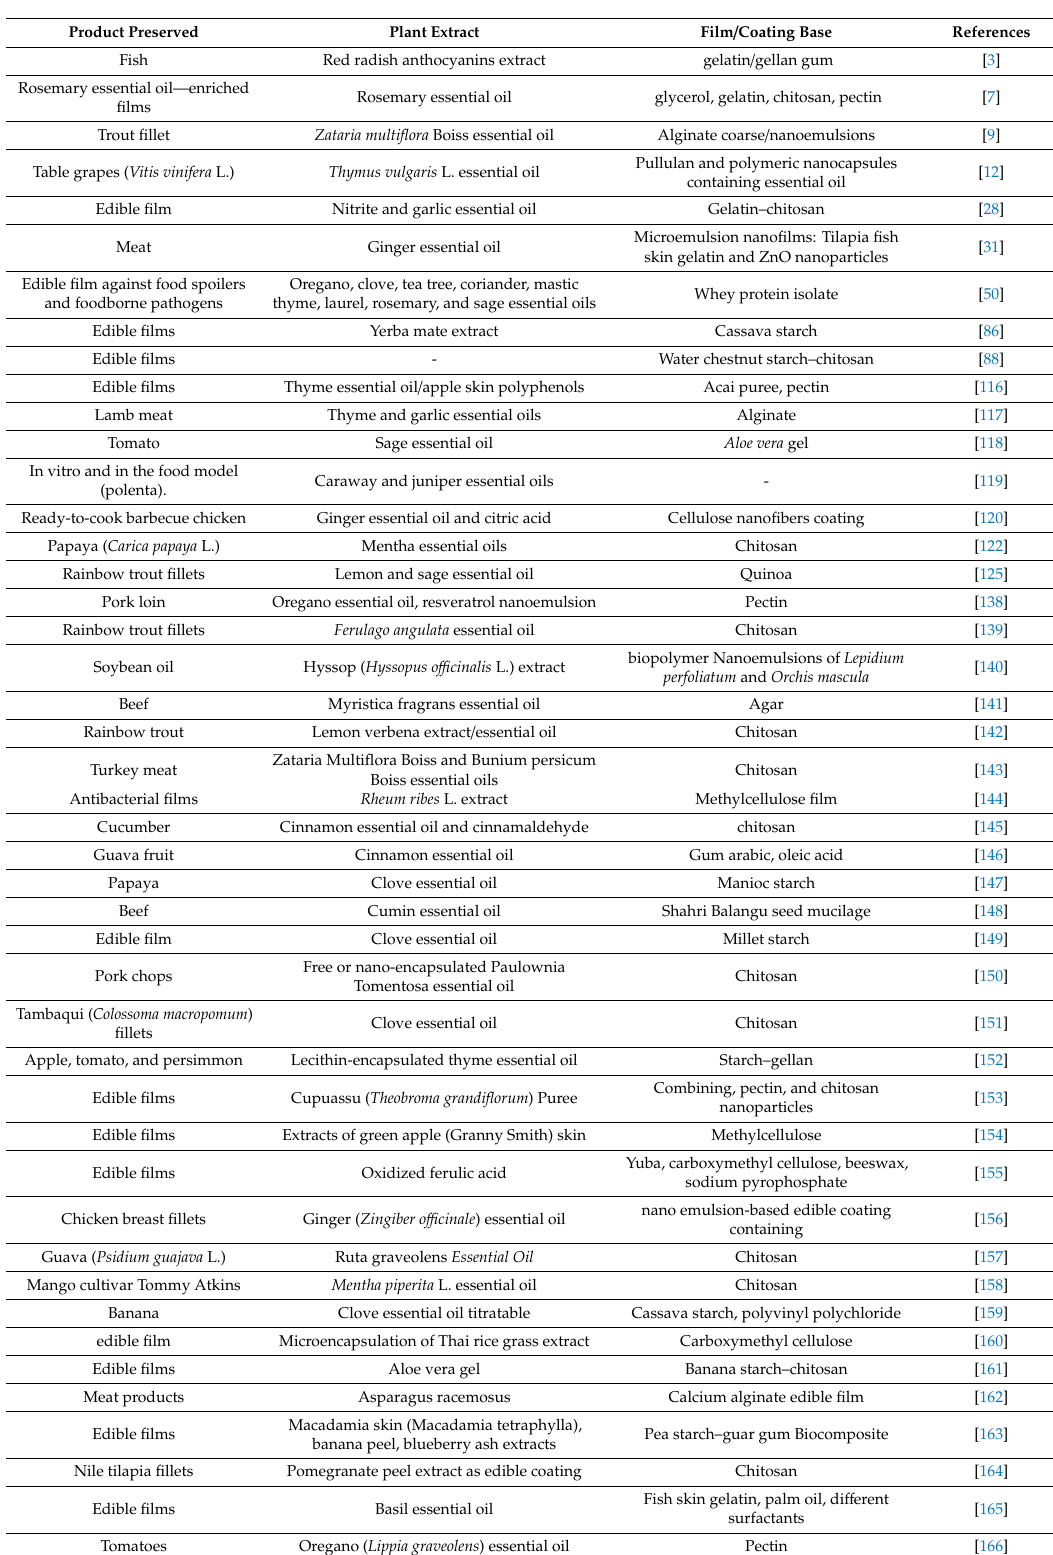
Table 1. Application of plant extracts in food